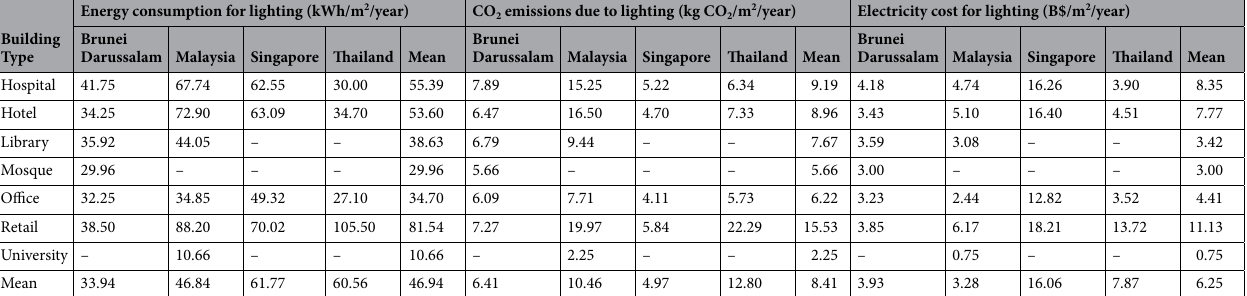
Table 2. Energy consumption, CO 2 emissions and electricity cost of lighting for commercial buildings in Southeast